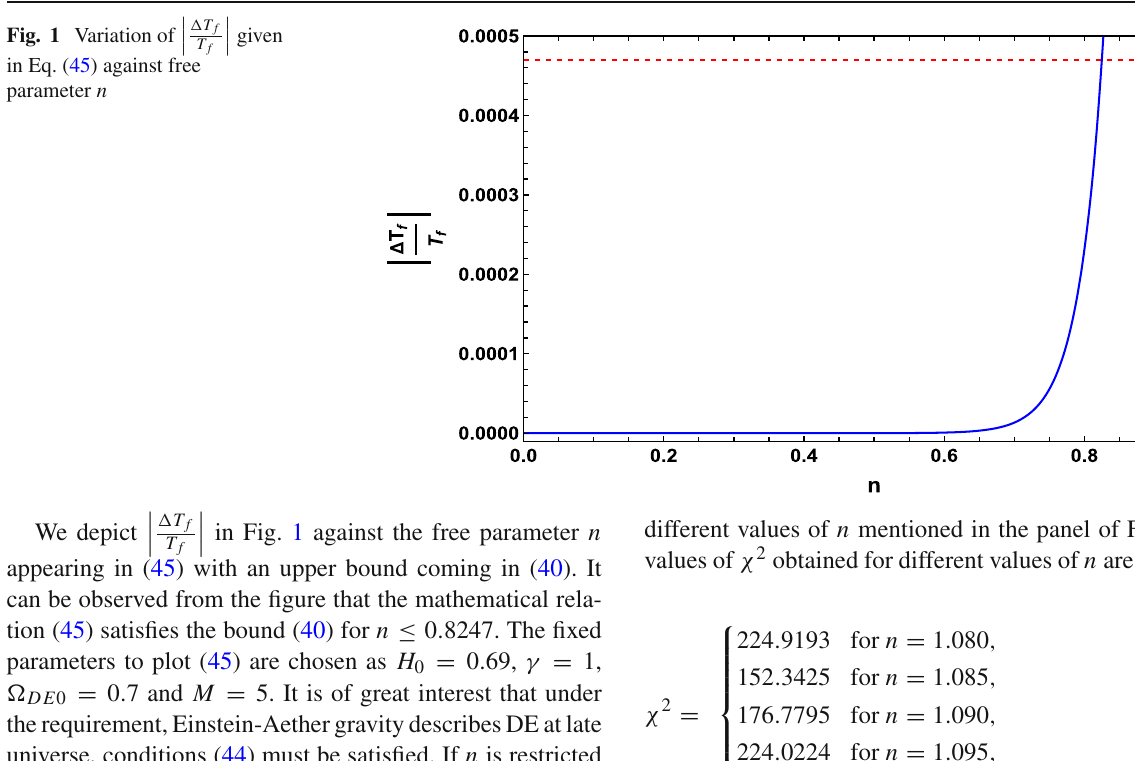
Fig. 1 Variation of in Eq. (45) against free parameter